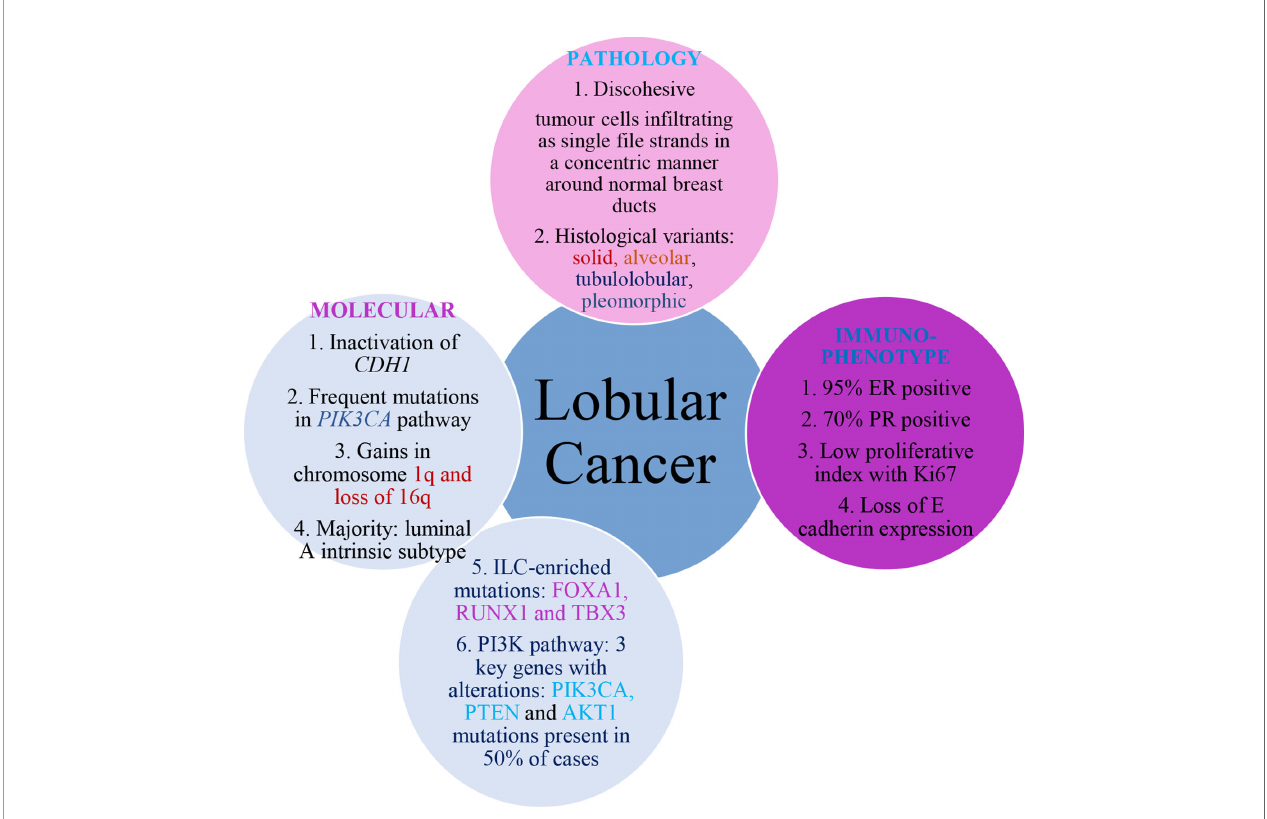
FIGURE 4 | Molecular, pathology, and immunophenotype features of